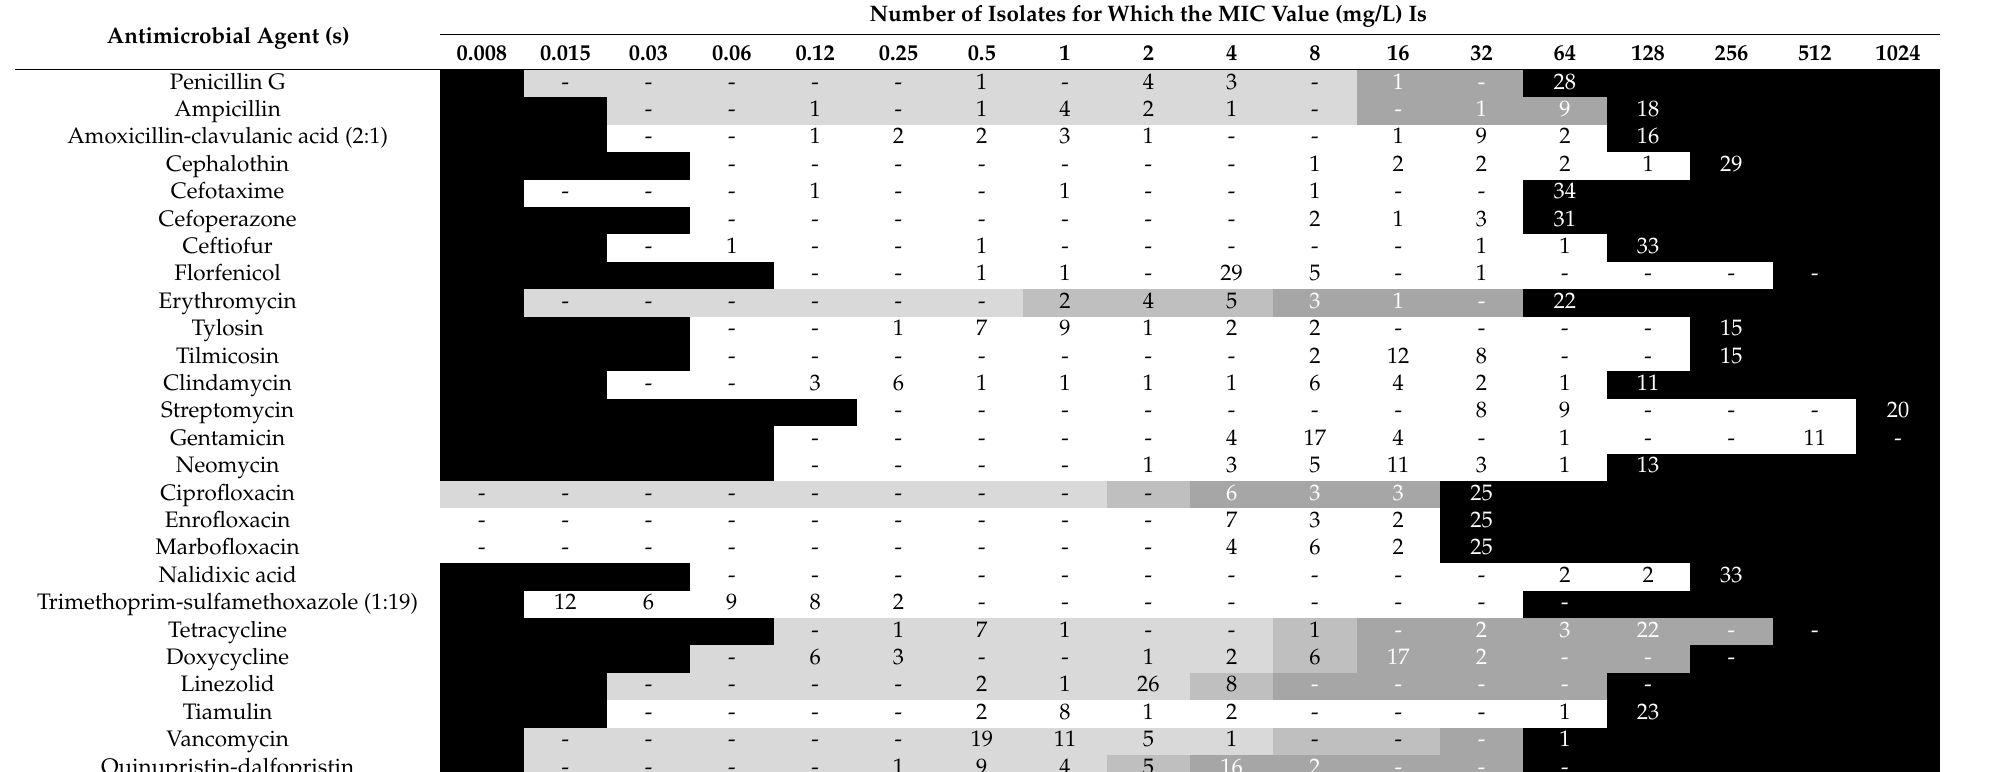
Table 2. Minimal inhibitory concentrations of the 37 canine and feline E. faecium isolates. Antimicrobial Agent